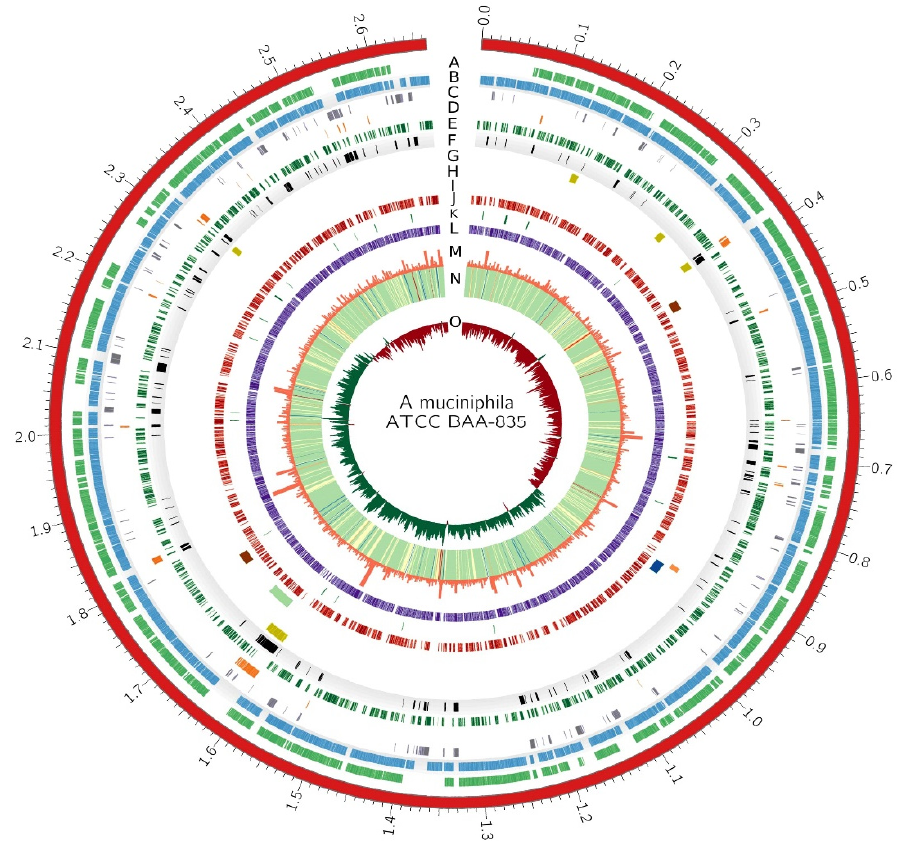
Figure 11. Circos plot of A. muciniphila ATCC BAA 835 . Different layers of the circos are represented